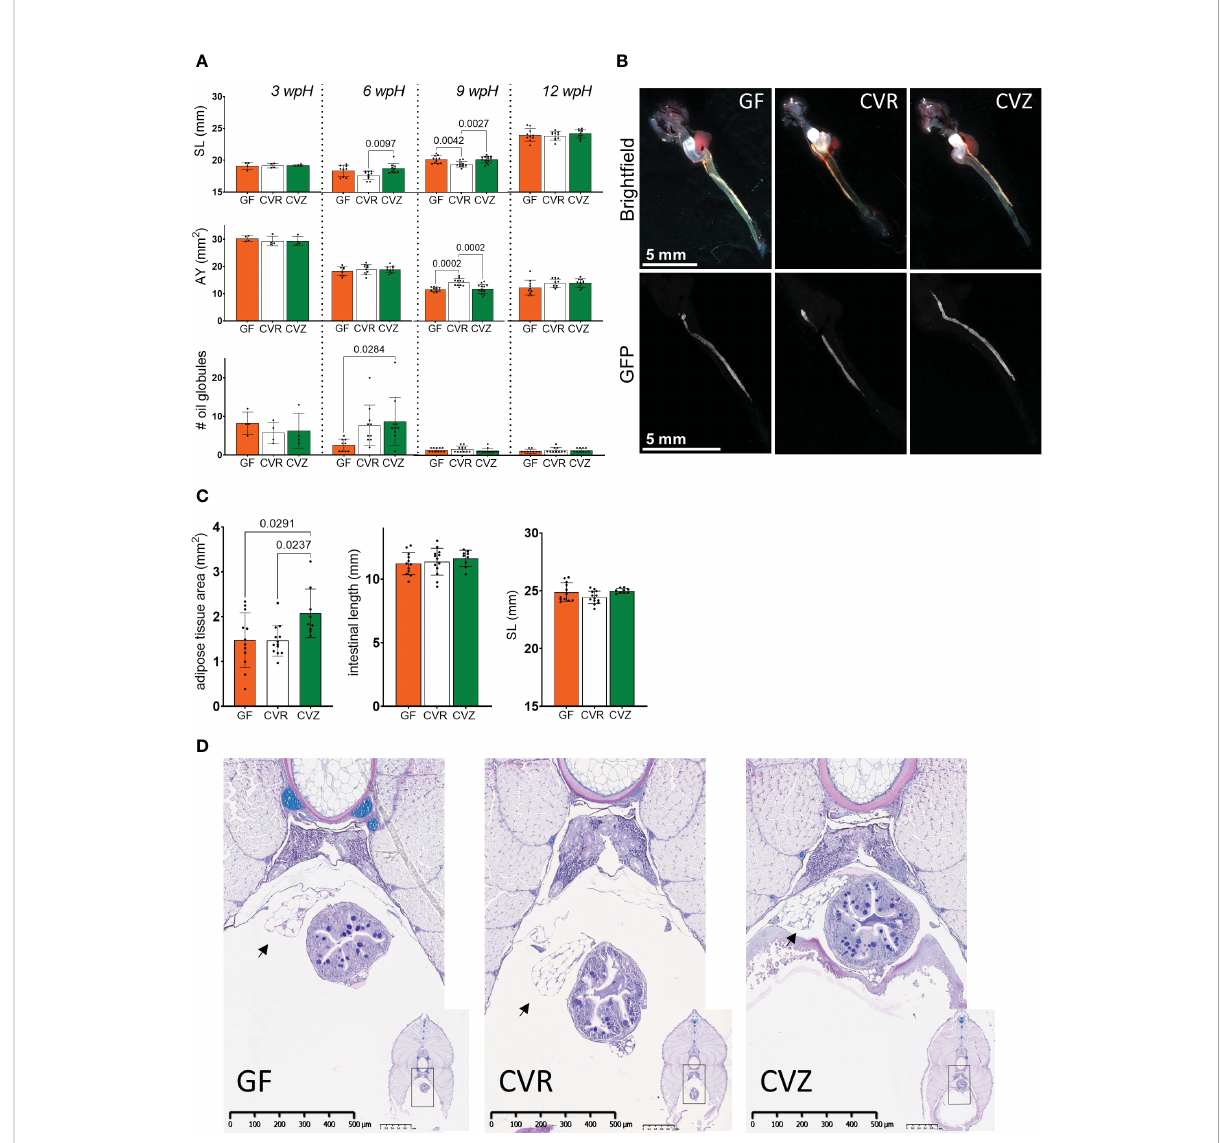
FIGURE 4 Use of the novel gnotobiotic system to study the microbial in fl uence on Atlantic salmon yolk sac fry growth, yolk consumption, and adipose tissue accumulation (A) Measurements of standard length (SL), area of the yolk (AY), and number of oil globules from fry housed in GF, CVR, and CVZ fl asks at 3 wpH, 6 wpH, 9 wpH, and 12 wpH. Two replicate fl asks were sampled per microbial condition at each timepoint. Nine to fourteen fry were sampled per condition, except at 3 wpH (see Methods). The morphometric characteristics measured are illustrated in Supplementary Figure 3A. Bar graphs represent the mean of these measurements ± SD. Means were compared to each other using one-way ANOVA and post- hoc Tukey ’ s multiple comparison tests. (B) Representative images of dissected whole gastrointestinal tract, from the esophagus (posterior to gills) to the distal intestine of fry from GF, CVR, and CVZ fl asks (top row, bright fi eld channel). Bottom row shows corresponding Nile red staining fl uorescence images of adipose tissue associated with the intestine. Selected fry are representative of the mean intestinal length per treatment at 13 wpH. Difference in magni fi cation was only used to display the entire length of the GI tract. (C) Measurements of the adipose tissue associated with the dissected intestine of fry from GF, CVR, and CVZ fl asks at 13 wpH. Four to fi ve replicate fl asks were sampled, and a total of nine to thirteen fry per microbial condition. Corresponding measurements of the length of the intestine (measured posterior to the esophagus to the distal intestine) and SL are also included. Bar graphs represent the mean of these measurements ± SD. Means were compared to each other using one-way ANOVA and post-hoc Tukey ’ s multiple comparison tests. (D) Representative images of stained cross sections obtained at the mid-posterior body segment (see Methods and Supplementary Figure 3A) of GF, CVR, and CVZ fry at 12 wpH. Higher magni fi cation images show the morphology of adipose tissue (arrows) adjacent to the intestine. Lower magni fi cation images are included for orientation in the section, and the black box marks the approximate region of interest. Three fry were sampled per duplicate fl ask, thus a total of six fry per condition were processed for histology and examined to score the presence of adipose tissue associated to the intestine and other